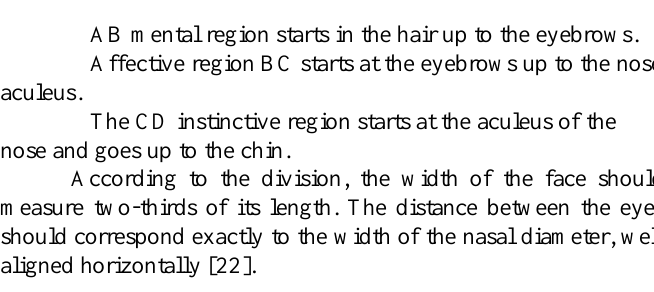
Figure 2: View of the three symmetrical parts of the human face. Source: